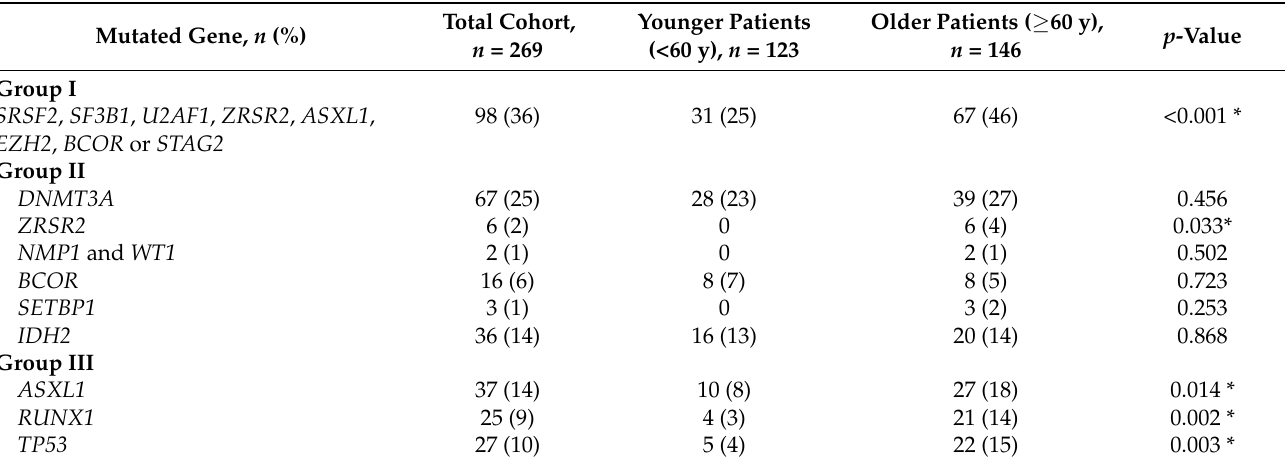
Table 3. Frequency of selected gene mutations according to